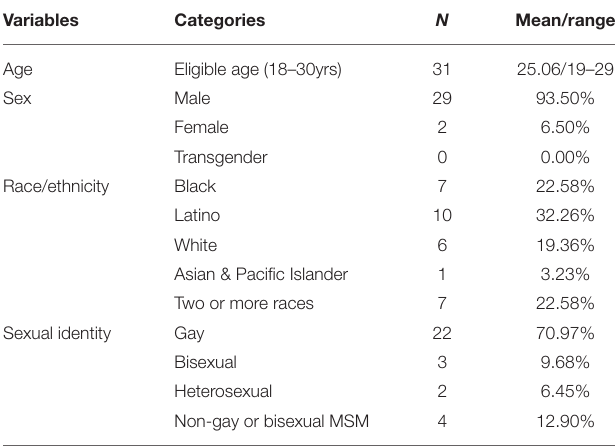
TABLE 1 | Demographics of Study